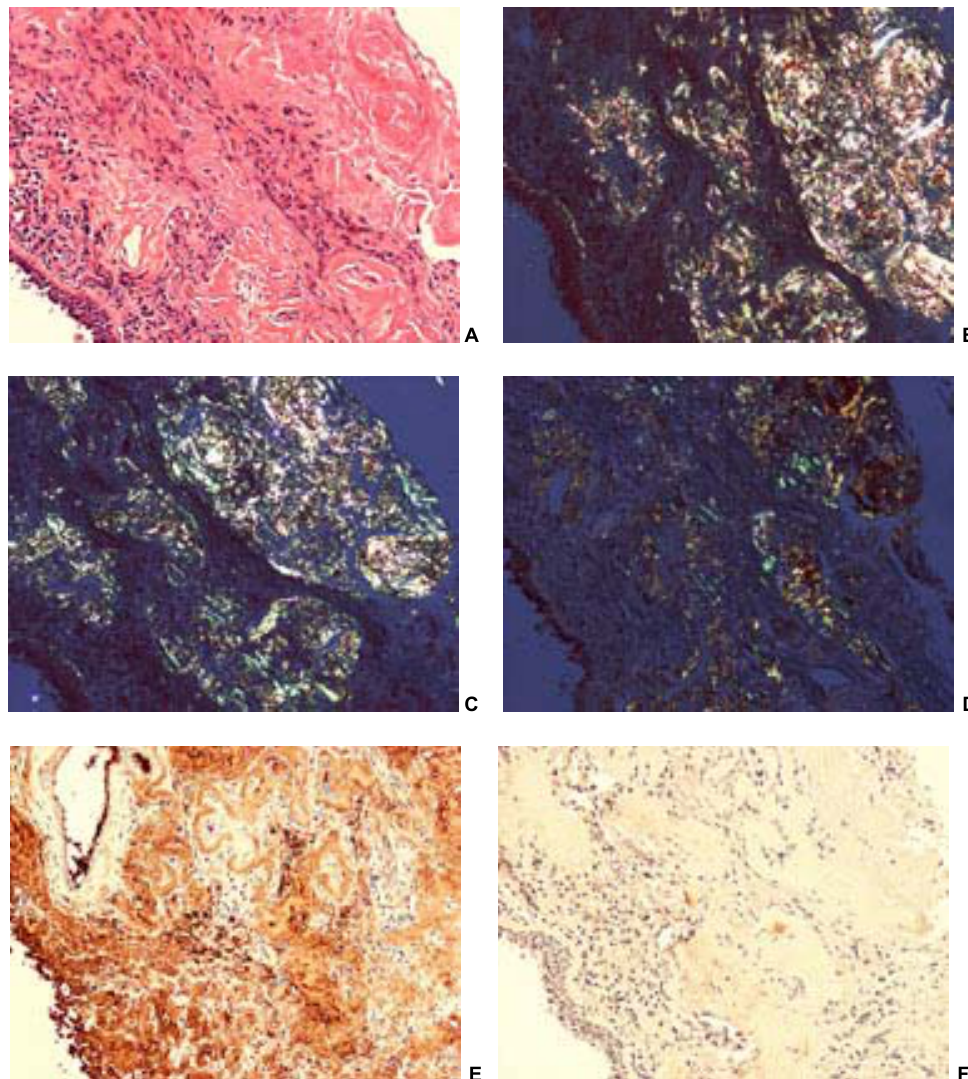
FIGURE 3A–F. Trachea. Localized AL- λ amyloidosis. (A) Hematoxylin and Eosin. × 100. (B) Same as Fig. 3A. Congo red staining according to Romhányi, without alcoholic differentiation, covered with gum arabic, viewed under polarized light. × 100. (C) Same as Fig. 3A. Performate pretreatment (for 1 sec), Congo red staining, viewed under polarized light. Localized AL amyloid deposits are resistant to performate pretreatment ( for 1–20 sec). × 100. (D) Same as Fig. 3A. KMnO 4 oxidation (for 5 min). Localized AL amyloid deposits are resistant to KMnO 4 oxidation (for 1 min – 10 min). × 100. (E) Same as Fig. 3A. Localized AL amyloid deposits are positive for antihuman λ -light chain (polyclonal antibody N1569; DAKO, Glostrup, Denmark), Streptavidin-biotin complex/horseradish peroxidase reaction. × 100. (F) Same as Fig. 3A. Localized AL amyloid deposits are negative for antihuman amyloid A component 1:100 (monoclonal antibody MO759; DAKO, Glostrup, Denmark), Streptavidin-biotin complex/horseradish peroxidase reaction. ×